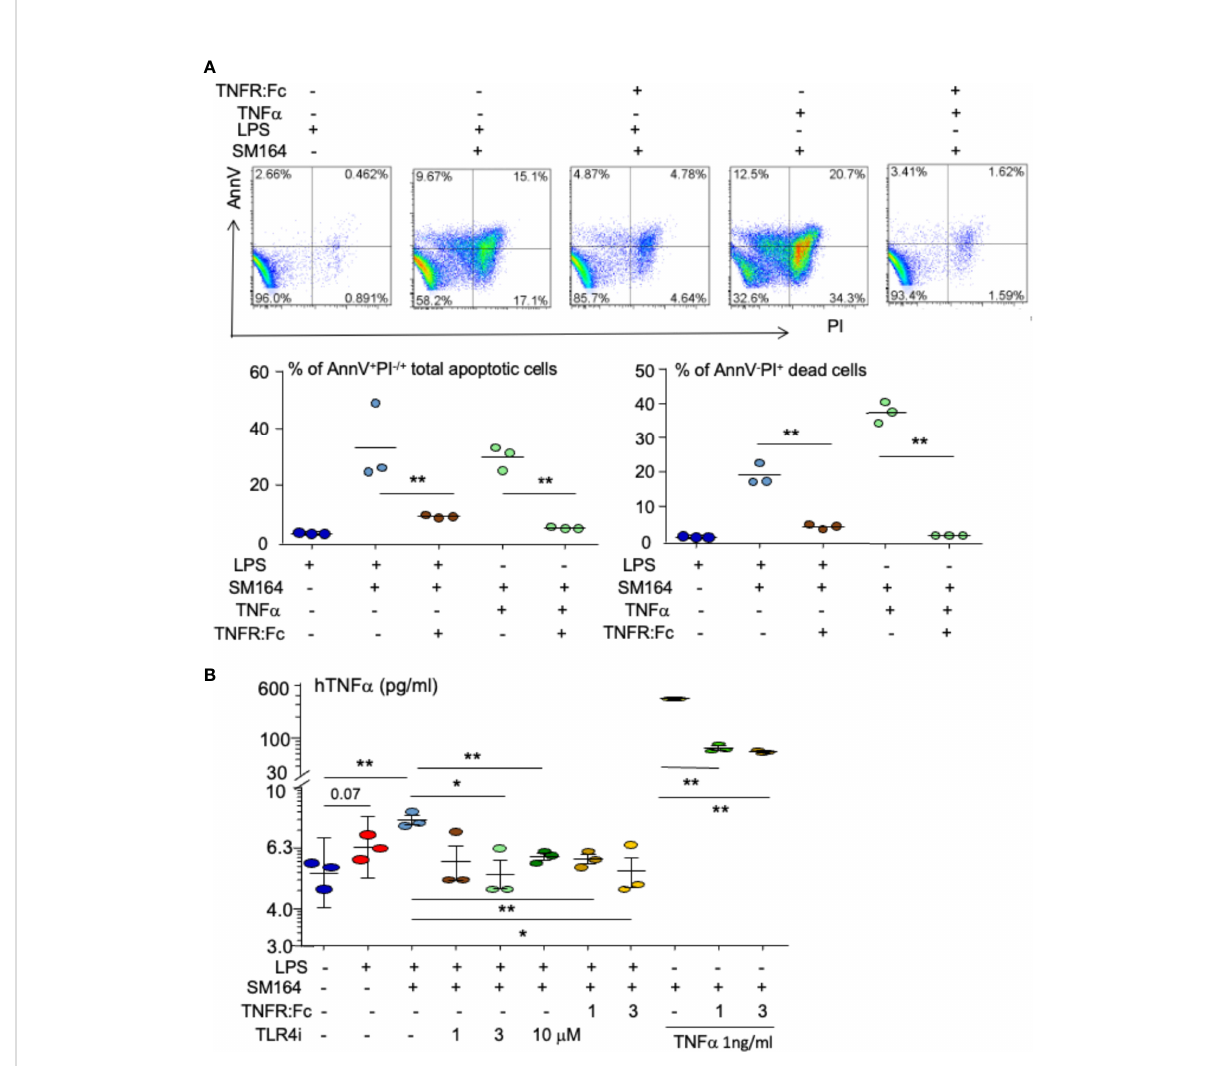
FIGURE 6 Autocrine TNF a mediated by TLR4 is critical for LPS triggering SM-164-induced apoptosis of MDA-MB-231 cells. (A) MDA-MB-231 cells were treated overnight with SM-164 (SM) 3 nM plus either 100 ng/ml of LPS or 1 ng/ml TNF a or with their combination with TNFR: Fc. AnnV + PI − /+ apoptotic cells were analyzed by fl ow cytometry. The data were from three repeat samples in one experiment. *p < 0.05 and **p < 0.01 between the indicated groups. (B) The culture medium of MDA-MB-231 cells, as in panel A and Figures 3 and 4, were collected. TNF a levels were tested by ELISA. The data were from three repeats. *p < 0.05 and **p < 0.01 between the indicated groups. LPS,